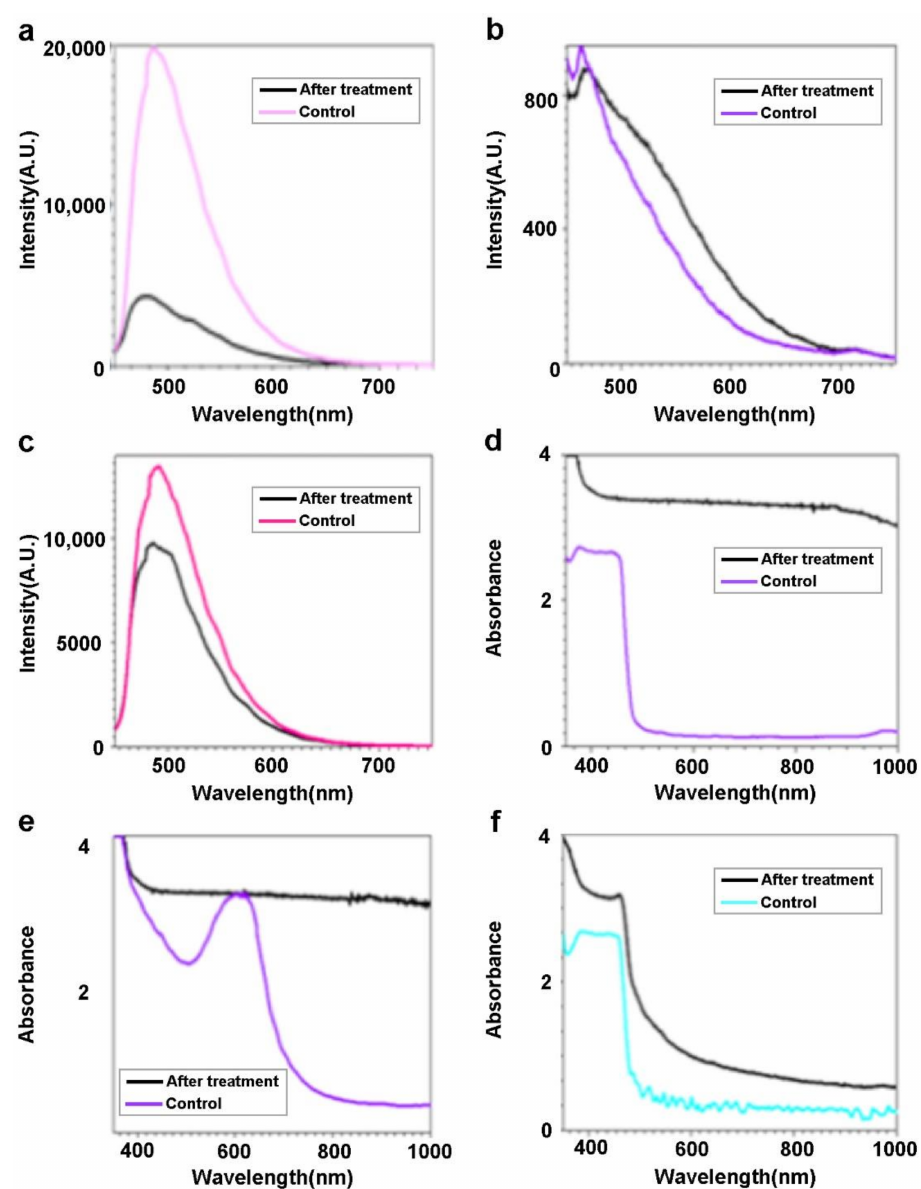
Figure 7. ( a ) Fluorescence of FSS after degradation treatment under white light irradiation. ( b ) Fluorescence of R6G after degradation treatment under white light irradiation. ( c ) Fluores- cence of Dye 1 after degradation treatment under white light irradiation. ( d ) Absorption of FSS after degradation treatment under white light irradiation. ( e ) Absorption of R6G after degradation treatment under white light irradiation. ( f ) Absorption of Dye 1 after degradation treatment under white light